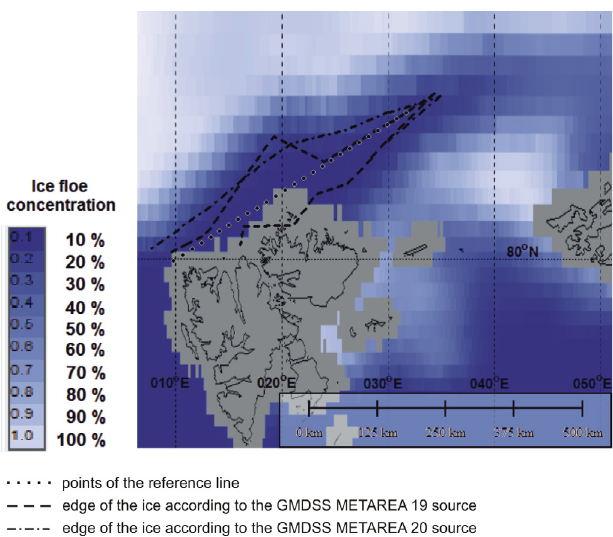
Fig. 4. Map of sea ice concentration in GRIB format (visualization using BallGate GRIB Weather File Viewer Professional software)